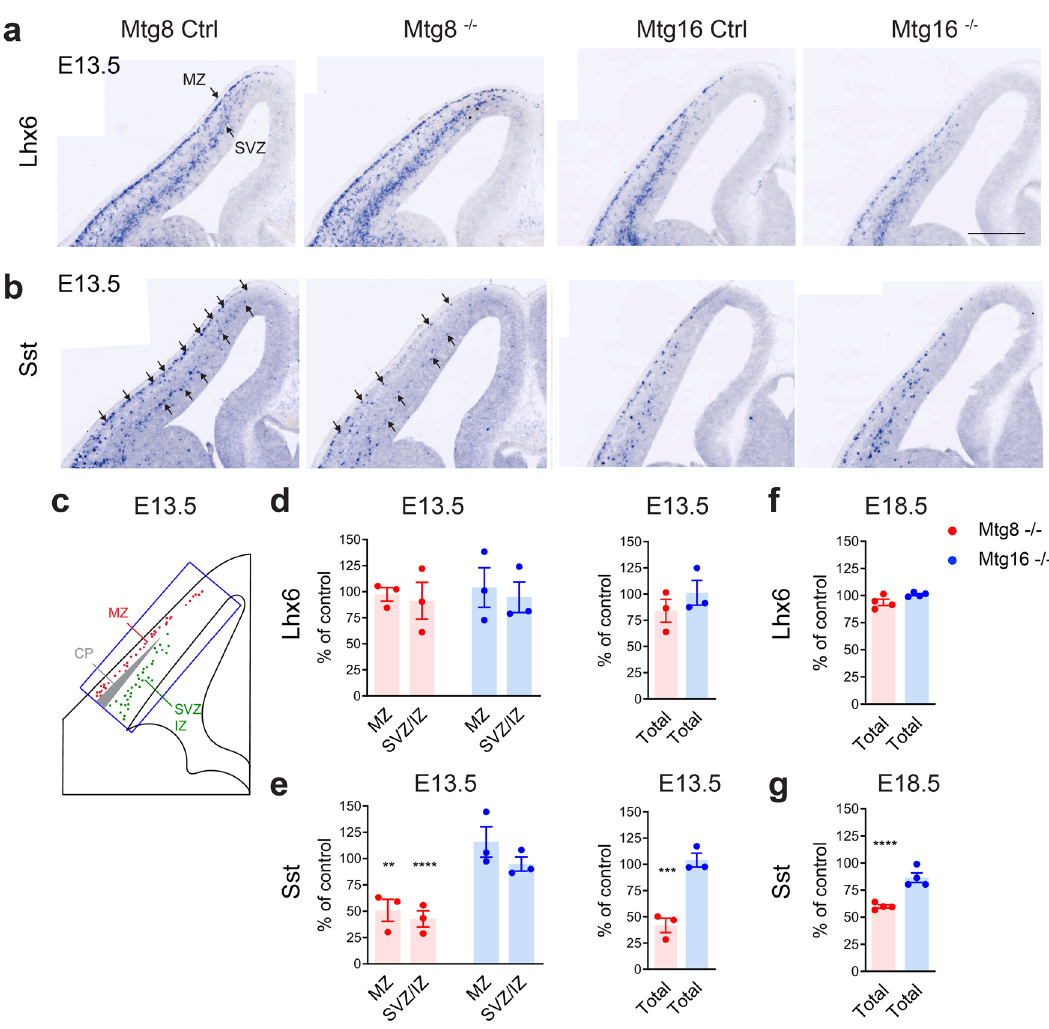
Fig. 2 | MTG8 is required for embryonic speci fi cation of SST interneuron sub- sets. a , b Lhx6- ( a ) and Sst- expressing ( b ) MGE-derived cortical interneurons migrating into the developing neocortex at E13.5 in control (Ctrl), Mtg8 − / − and Mtg16 − / − embryos. c Scheme showing how Lhx6 and Sst quanti fi cation was per- formed for the data shown in Fig. 2d, e. A rectangle stretching from the cortico- striatalboundarytothetipofthedevelopingneocortexwasusedtode fi nethearea of counting. Migrating interneurons in the MZ and SVZ/IZ as well astotal numbers werequanti fi ed.Thesamerectanglewasusedforallembryosexaminedinorderto